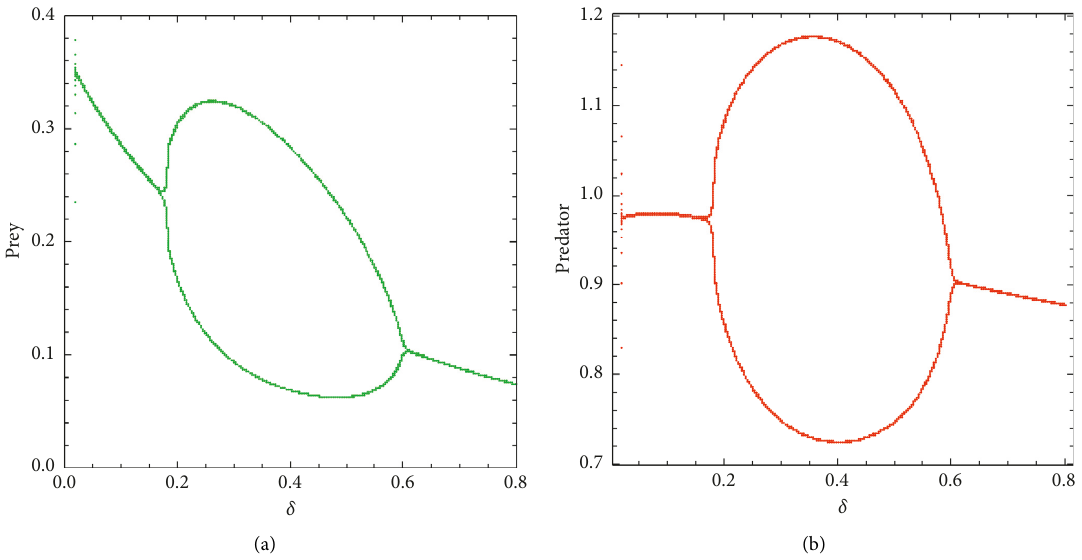
Figure 6: The bifurcation diagram of the model (51) with m